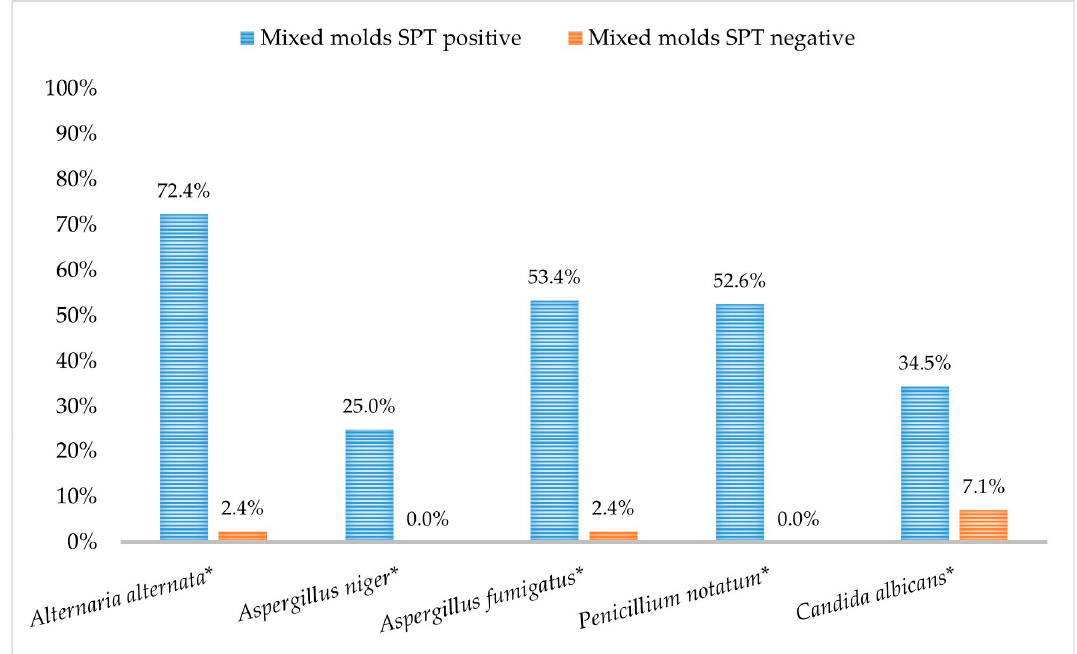
Figure 3. Fungi sensitization patterns in the studied patients by immunoblot assay. Data were analyzed by Fisher’s exact test, and significant differences was defined as * p < 0.001 (N = 200).